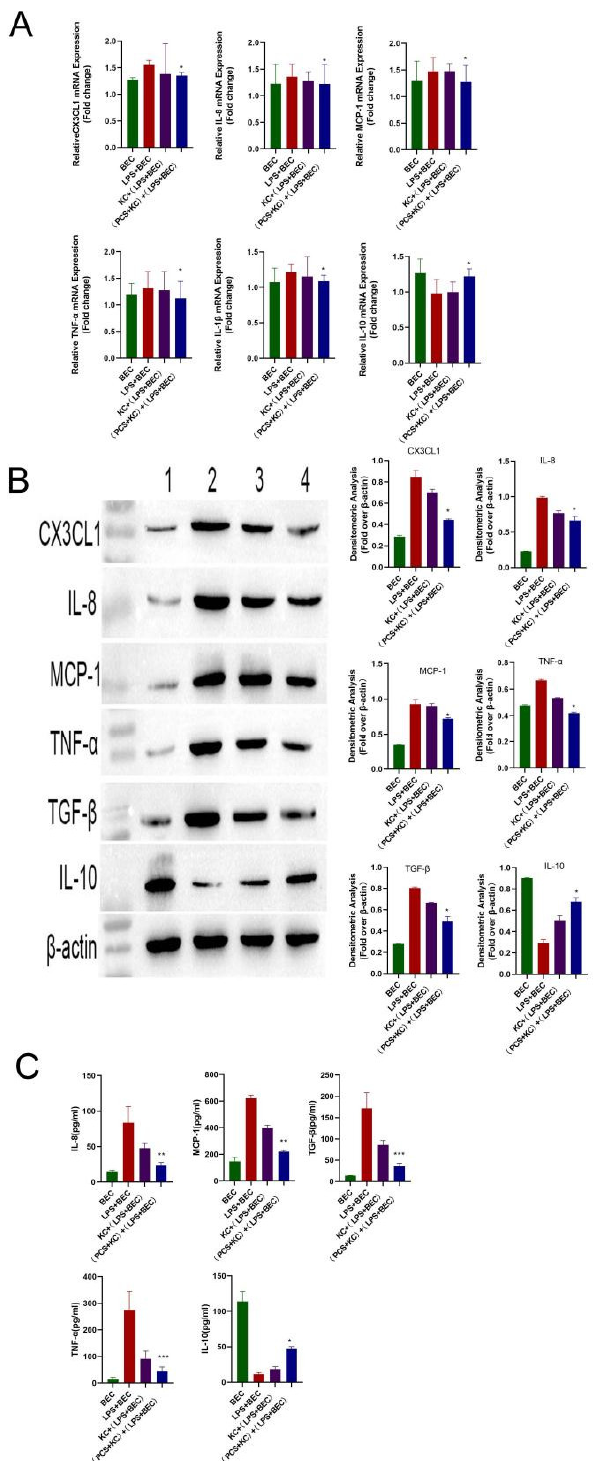
Figure 6. PCS protects LPS-injured bile duct epithelial cells via Kupffer cells. ( A ) mRNA and ( B ) protein levels of CX3CL1, IL-8, MCP-1, TNF-α, IL-1β, and IL-10. ( C ) IL-8, MCP-1, TNF-α, IL-1β, and IL-10 levels measured by ELISA in co-culture supernatant. * p < 0.05, ** p < 0.01, and *** p < 0.001 vs. LPS + BEC group. 1: BEC group; 2: LPS + BEC group; 3: KC + (LPS + BEC) group; and 4: (PCS + KC) + (LPS + BEC) group ( n = 3/group). KC, Kupffer cells; BEC, bile duct epithelial cells.